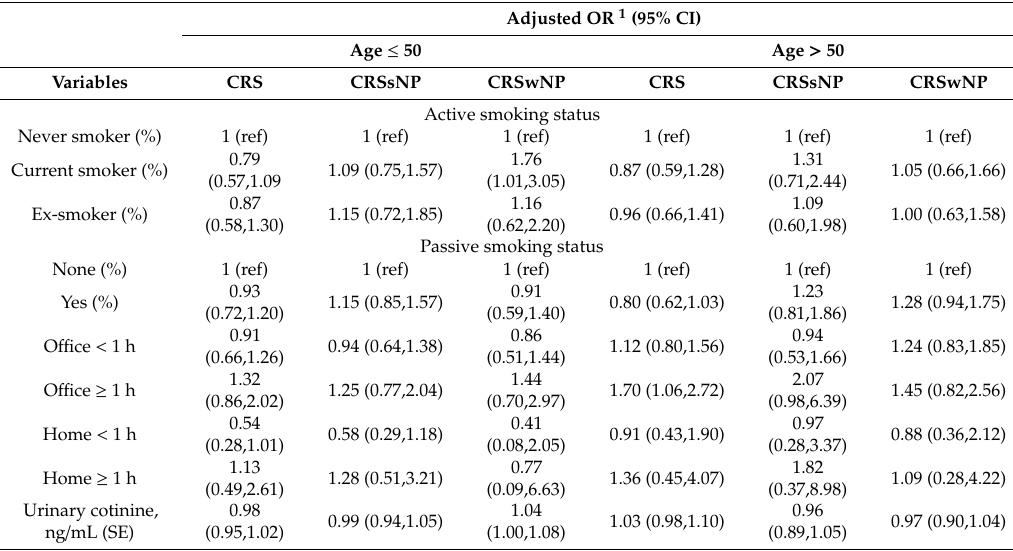
Table 3. Adjusted odds ratio for the association between cigarette exposure-related factors and chronic rhinosinusitis according to the age subgroup